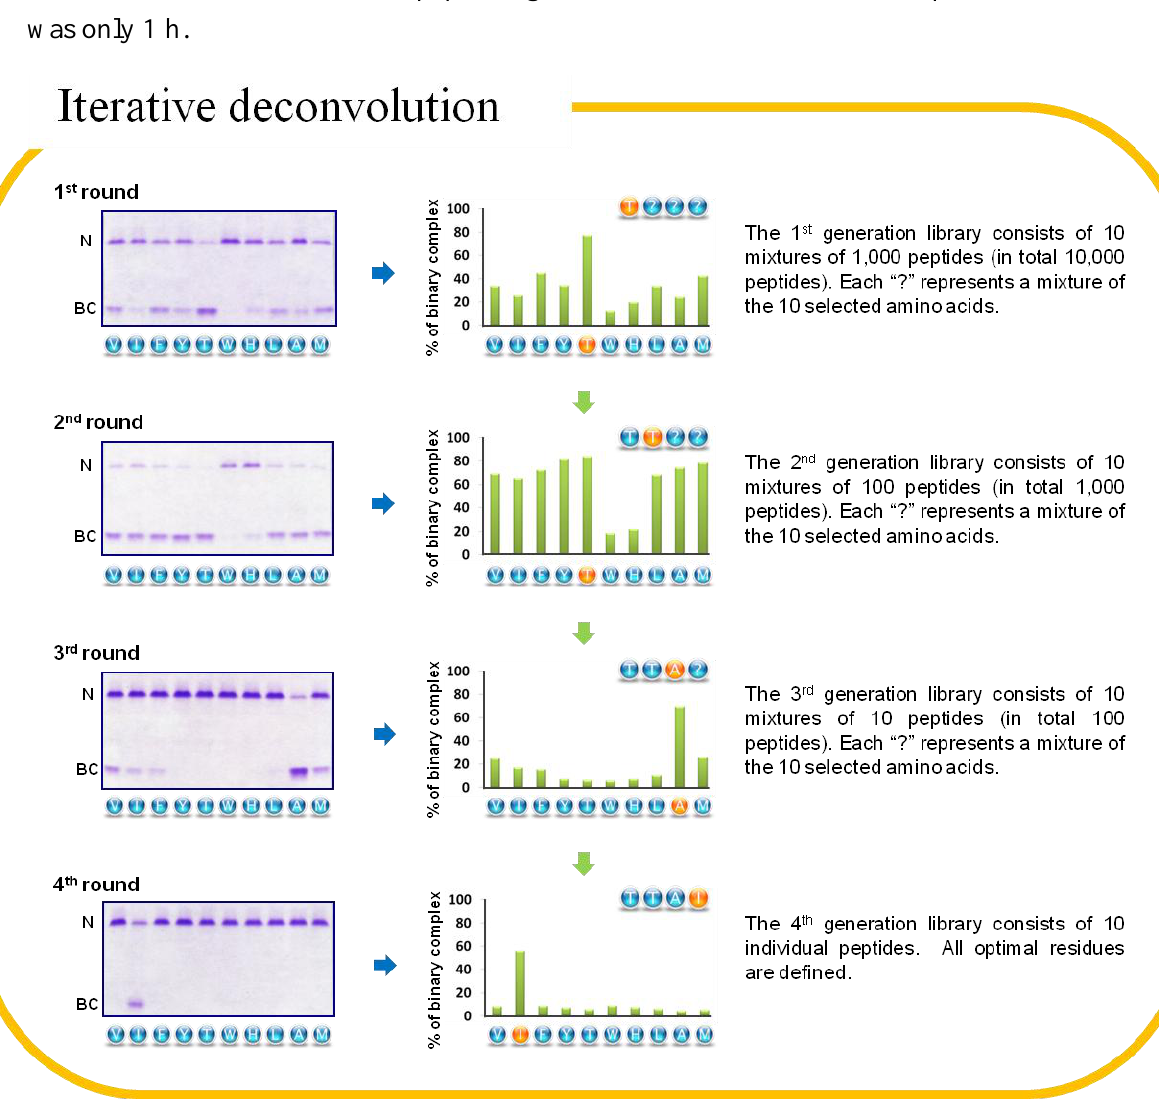
Figure 7. 8% ( w/v ) 8 M urea native-PAGE demonstrating the result of iterative deconvolution of Z α -antitrypsin (AT). The potency of each sub-library was determined 1 by percentage of binary complex (BC) formation, which was quantitatively measured by densitometric analysis. The most reactive sub-library in each screening cycle is indicated on the top right corner of each bar graph. All screenings were performed with a 10-fold molar excess of each individual peptide against Z-AT at 37 °C for 2 h except the last round was only 1